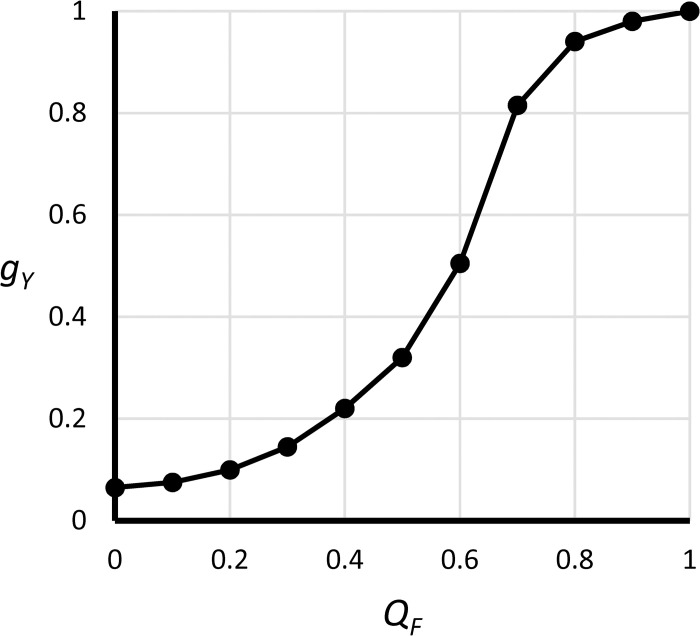
Graphical function gY(QF).